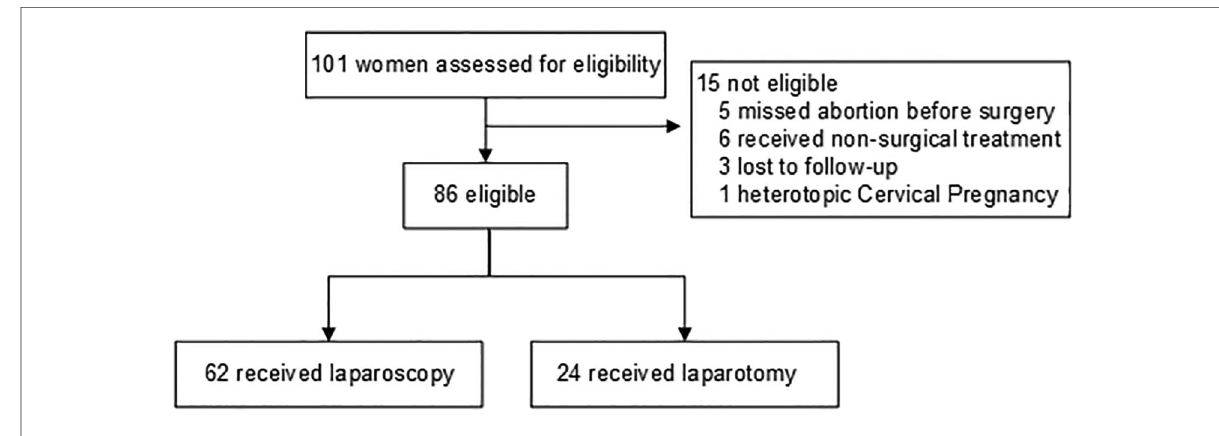
FIGURE 1 Flow chart of the selection of study